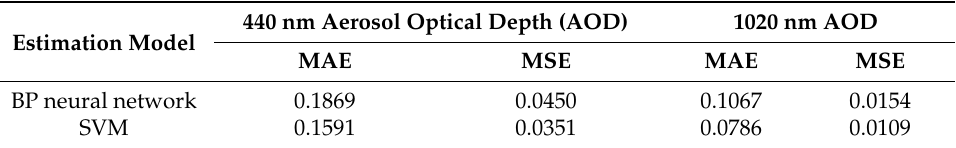
Figure 6. Estimation results of SVM models on the test data set. Table 3. Performance comparison for two estimation models on the test data set.